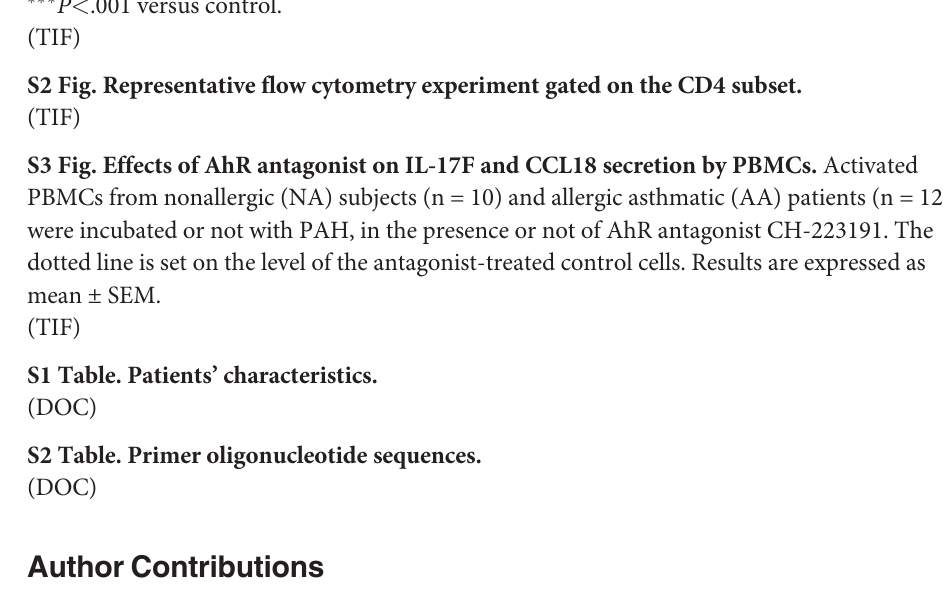
S1 Fig. Cytokine profile of PAH-stimulated PBMCs. IL-17F, TGF- β 1 and CCL18 secretion by activated PBMCs from nonallergic (NA) subjects (n = 10) and allergic asthmatic (AA) pa- tients (n = 12) incubated or not with PAH. Results are expressed as mean ± SEM. (cid:1) P < .05 and (cid:1)(cid:1)(cid:1)